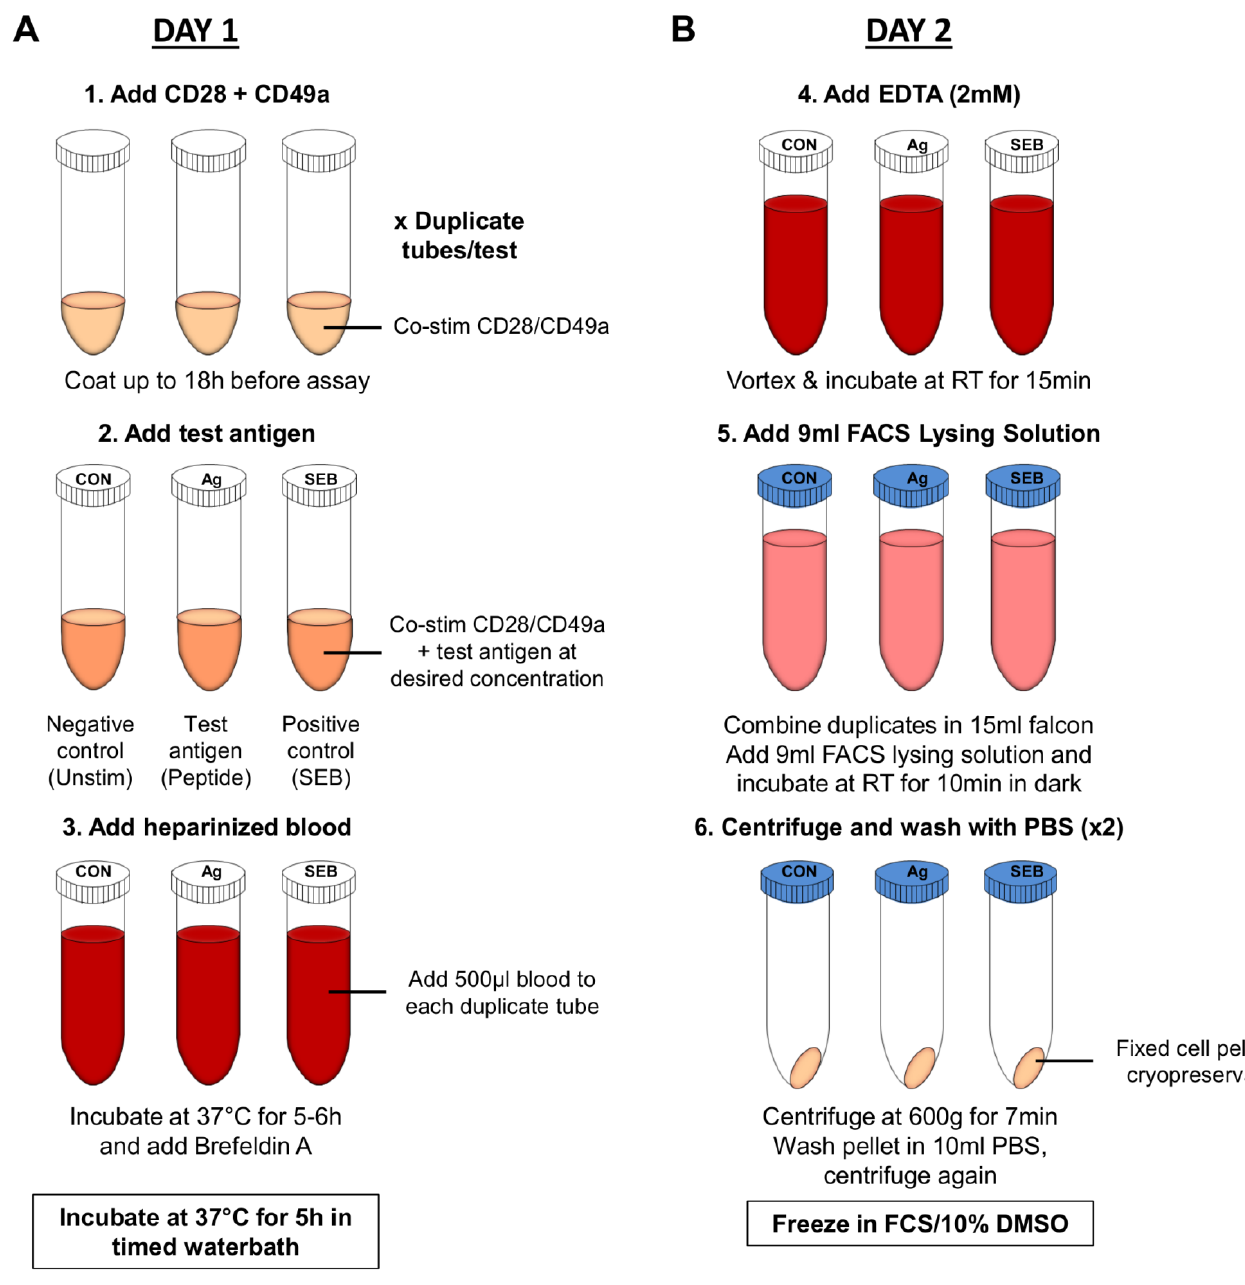
Figure 3. Schematic overview of Whole Blood Assay ( A ) Day 1: whole blood samples are stimulated with antigen, protein export inhibited and samples incubated overnight; ( B ) Samples are prepared for cryopreservation. Red cells are lysed and stimulated cells frozen down for future analysis by flow